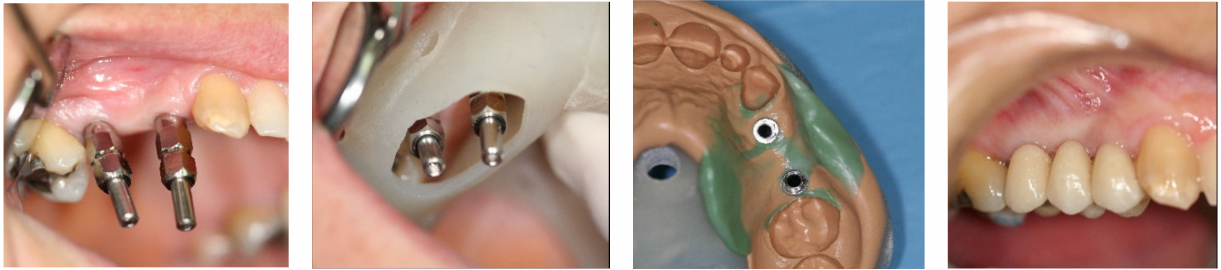
Figure 2. Prosthetic clinical protocol: Impression coping at 3 months post-placement and final, fixed-bridge